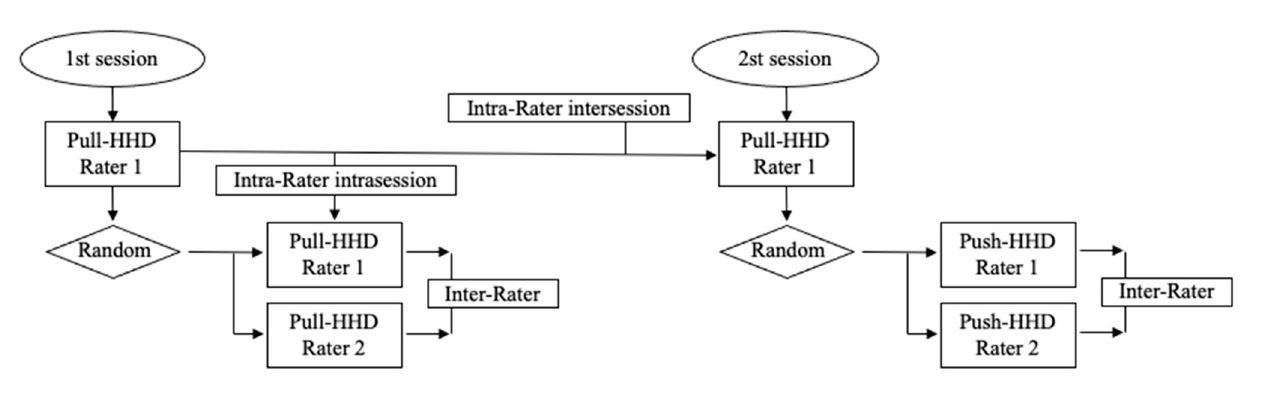
Figure 1. Flow chart represents a process of the study.